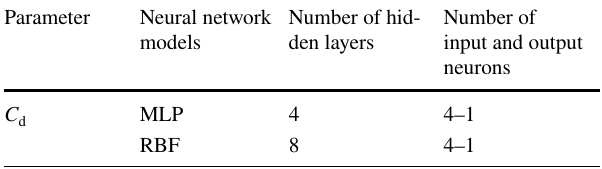
Table 2 The results of the simulation of the C d of the labyrinth weirs with quarter-round crests Parameter Neural network Number of hid- models den